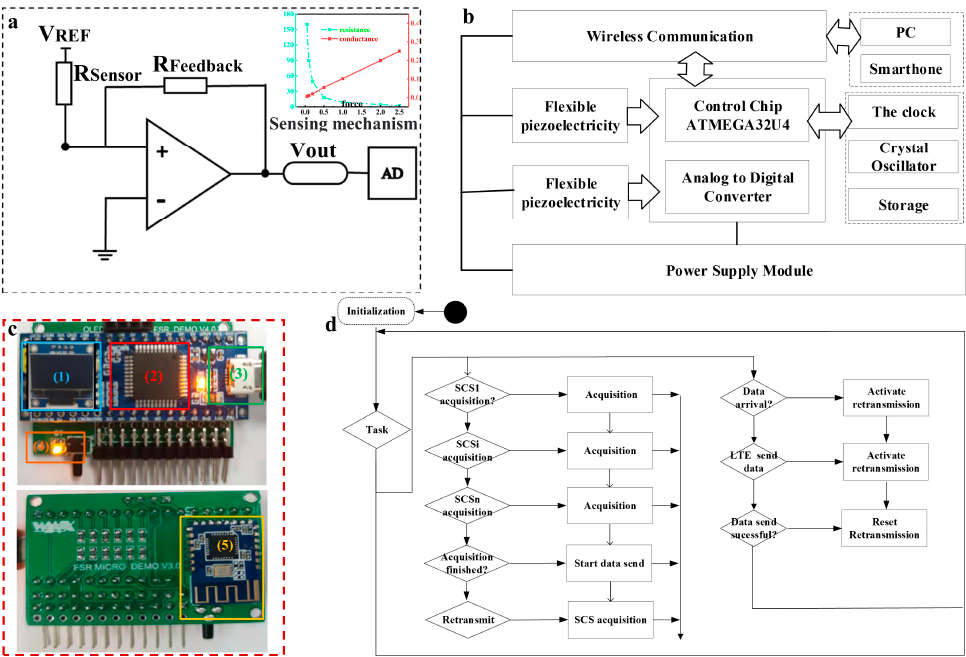
Figure 3. Flexible sensing system hardware design schematic diagram. ( a ) Sensor operation amplifier circuit; ( b ) the circuit block diagram of the sensor acquisition system; ( c ) sensor system hardware display, including: (1) real-time display; (2) ATMEGA32U4 chip; (3) universal serial bus (USB) serial port; (4) Bluetooth connection indicator; (4) light-emitting diode (LED) indicating lamp; (5) Bluetooth 4.0 module; (d) sensor signal processing process schematic diagram.